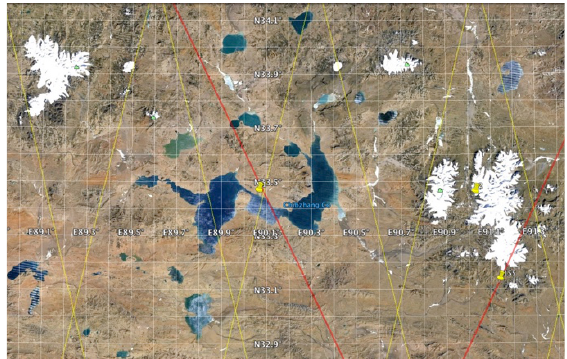
Figure 1. Geographic map of Chibuzhang Co and Dorsoidong Co. Red and yellow lines indicate groundtracks of Jason-2 and Envisat altimeters, respectively. This image is modified from Google Earth